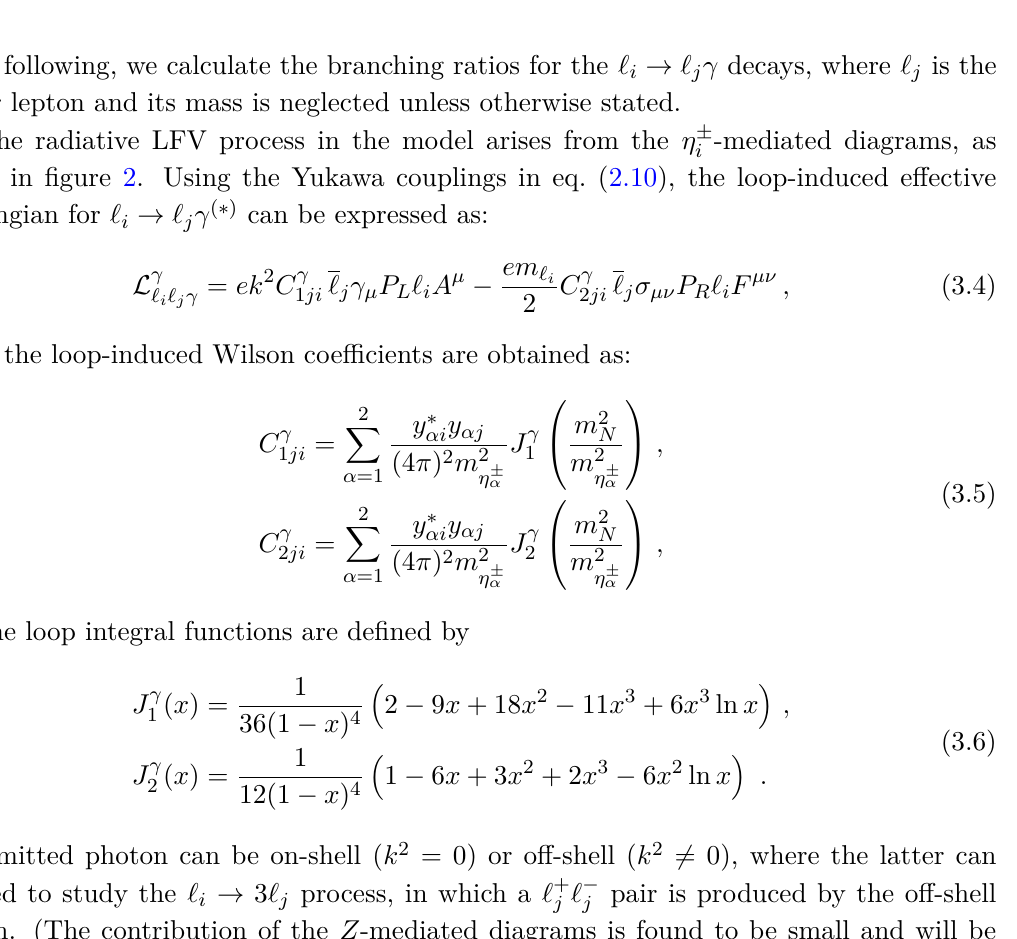
Figure 2 . One-loop Feynman diagrams for ‘ i → ‘ j γ ( ∗ )